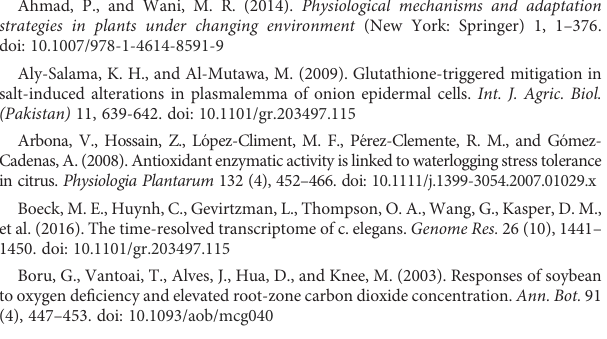
SUPPLEMENTARY TABLE 1 List of primers used for